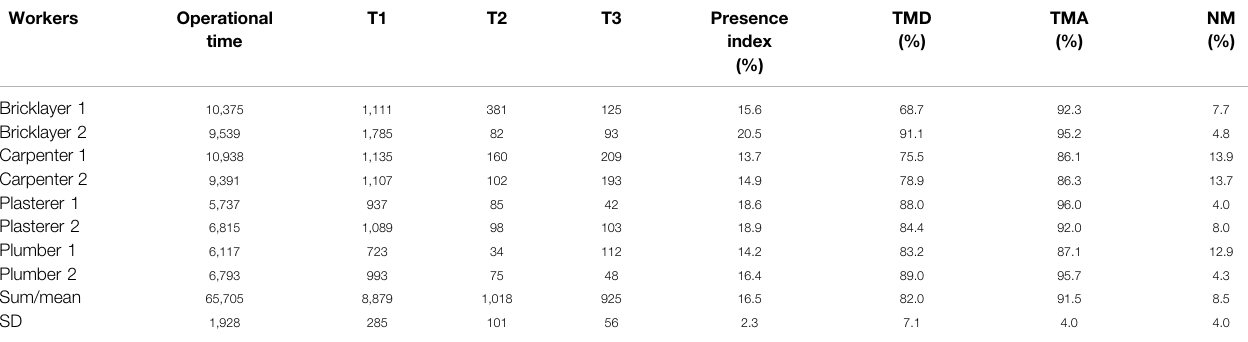
TABLE 7 | Summary of the time-matching levels for each individual worker (all numbers in minutes except percentages). Workers Operational T1 time